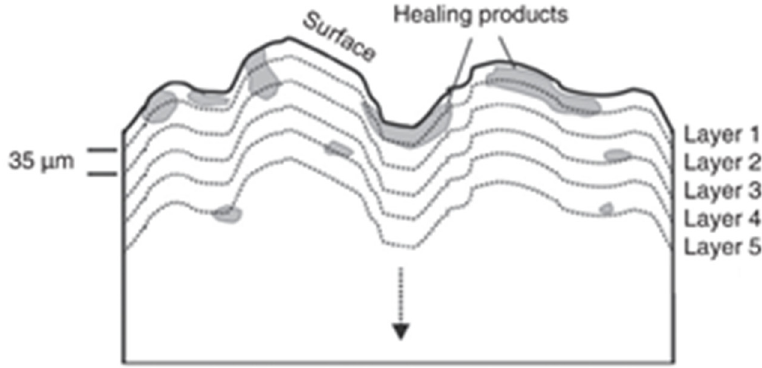
Figure 2. Distribution of healing products along fracture depth direction. Reprint with the permission from ref. [14]. Copyright 2021 Elsevier.